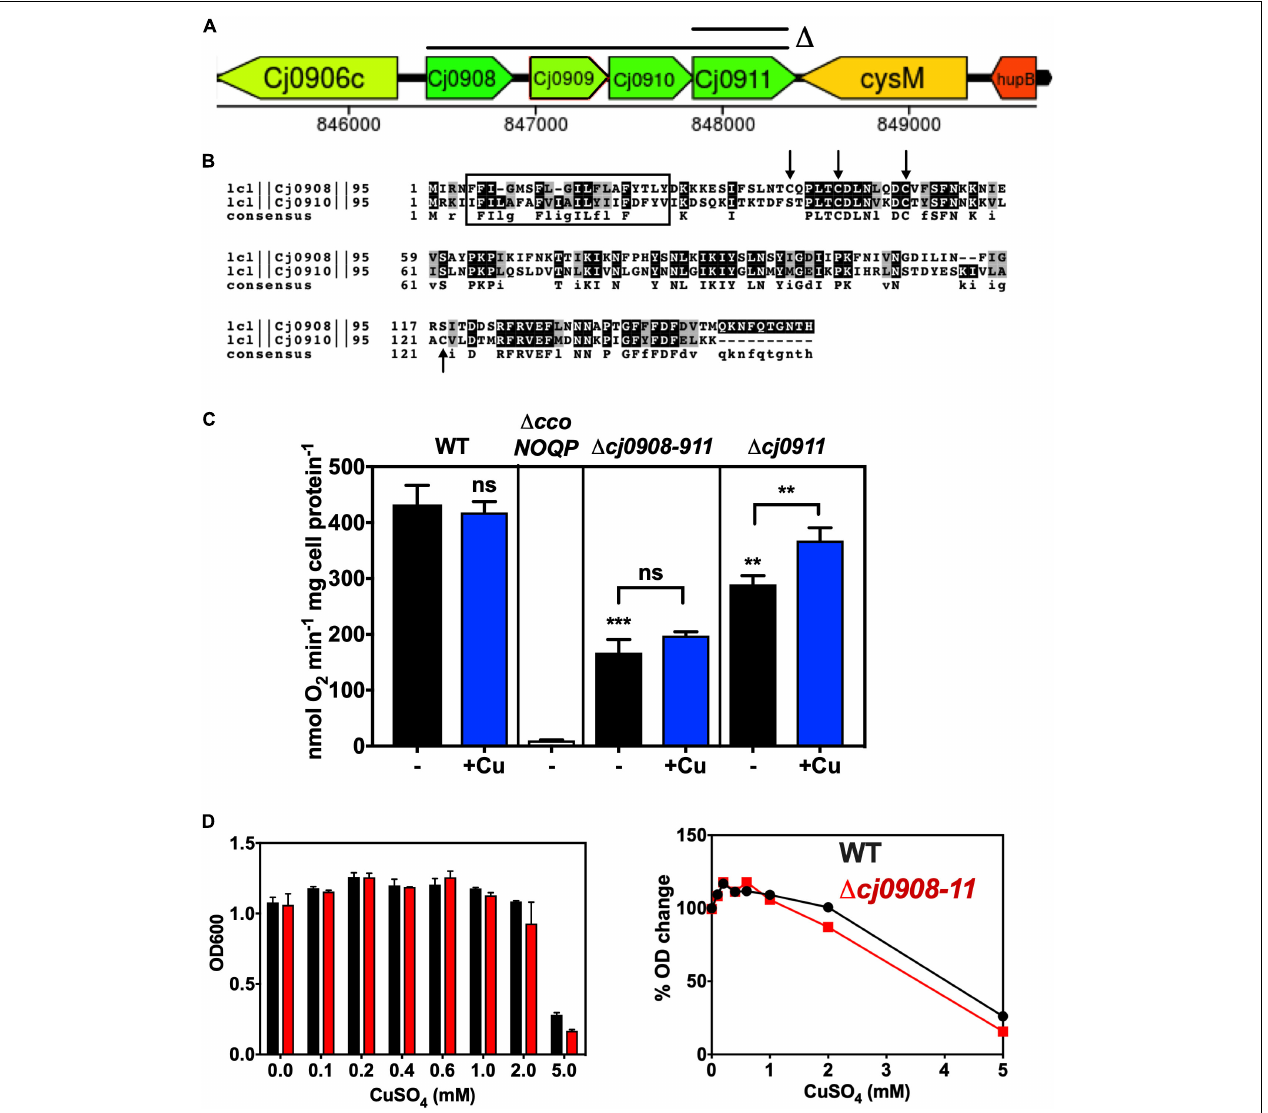
FIGURE 3 | Role of the cj0908–911 genes in Cco activity. (A) Organisation of the genomic region surrounding cj0908–911 and the extent of deletions made. An operon deletion plasmid in the pGEM3Zf vector was made using primers Cj0908 ISA F1 F, Cj0908 ISA F1 KR, Cj0911 ISA F2 KF and Cj0911 ISA F2 R ( Table 2 ) to create the flanks between which the Kan cassette was inserted. Image derived from campyDB (http://xbase.warwick.ac.uk/campydb/) and genes coloured by GC composition as in the legend to Figure 2 . (B) Alignment of Cj0908 and Cj0910 using T-COFFEE and BOXSHADE to show identical residues (Black boxes) and conservative substitutions (Grey boxes). The rectangular boxed area shows the single transmembrane helix predicted using TMHMM. Arrows highlight Cys residues in either or both proteins, which may have a redox function or bind Fe. (C) Cytochrome c oxidase activity measured with ascorbate/TMPD as electron donor. Wildtype, (cid:49) ccoNOQP , (cid:49) cj0908-cj0911 , and (cid:49) cj0911 cells were grown in Mueller-Hinton medium without any added copper or with copper sulphate added to 0.6 mM. The data are the average of triplicate cultures with error bars showing SD. Students t -tests were performed to check significance ( p > 0.05, ns; 0.01 > ** p > 0.001; 0.001 > *** p > 0.0001). The stars above the black bars represent the statistical significance of comparisons between the unsupplemented mutant and wild-type rates. (D) Copper sensitivity of wild-type and cj0908–911 mutant determined in the same way as described in the legend to Figure 3 .